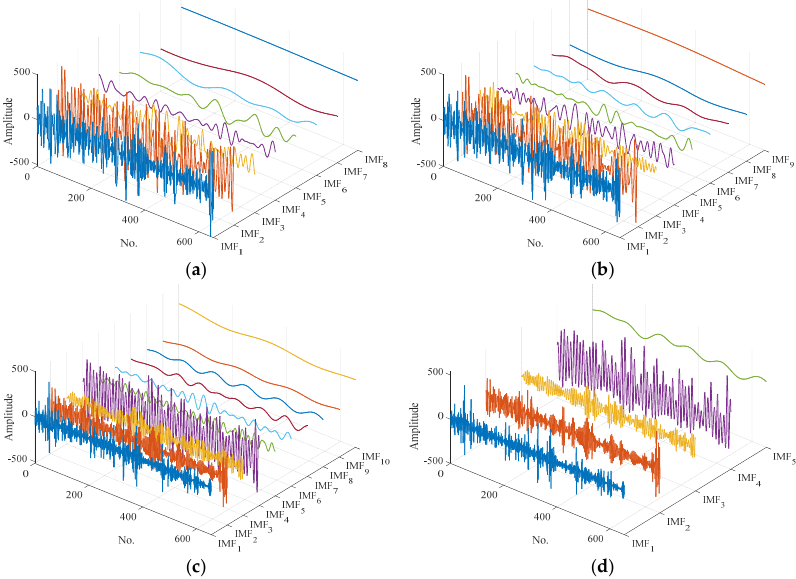
Figure 6. The decomposed subsequences are obtained by applying ( a ) empirical mode decomposition (EMD), ( b ) complete ensemble EMD with adaptive noise (CEEMDAN), ( c ) time-varying filter into the shifting process of EMD (TVFEMD), and ( d ) TVFEMD combined with sample entropy (SE)-based subseries Table 2. Parameter setting for all the methods.